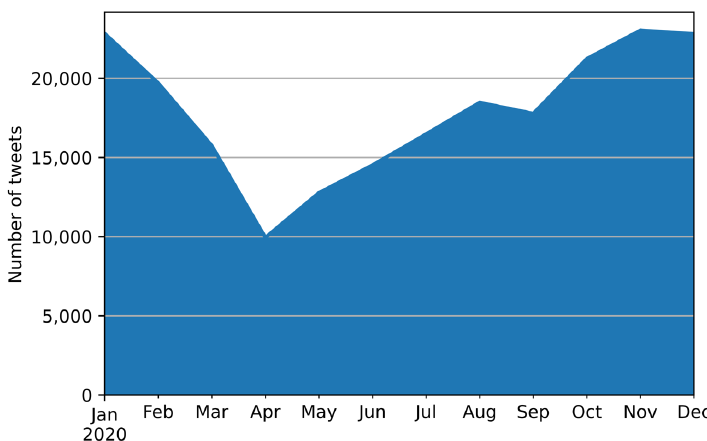
Figure 2. Monthly volume of tweets.